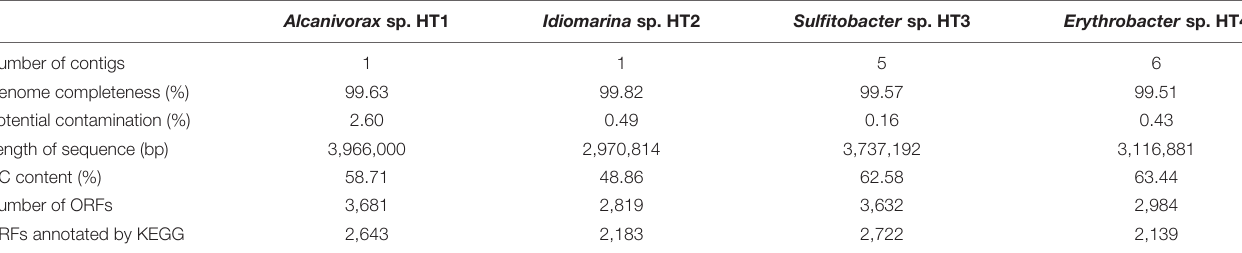
FIGURE 4 | Annotation of open reading frames (ORFs) derived from the metagenome of the cultured sediment samples based on the Kyoto Encyclopedia of Genes and Genomes (KEGG) database. The three cultured sediment samples were pooled for both Illumina and Oxford Nanopore sequencing followed by assembly and ORF prediction. The top 40 KEGGs in terms of number of corresponding ORFs are shown. TABLE 1 | Information on the four metagenome assembled genomes (MAGs) recovered from the metagenome of cultured sediment